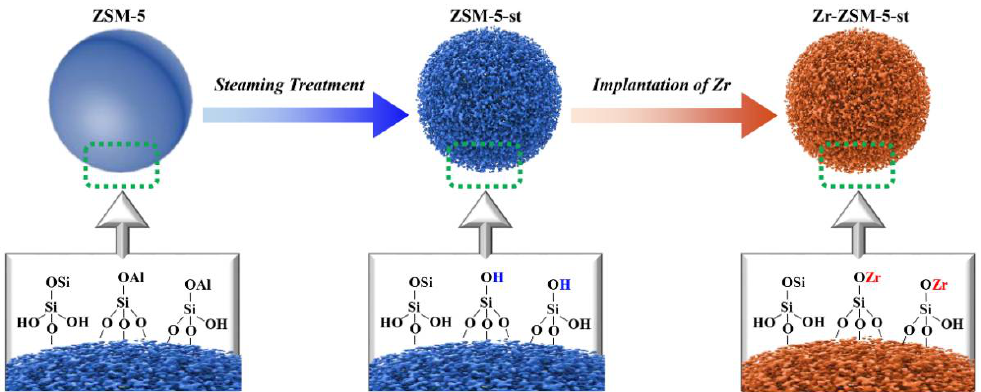
Figure 3. Plausible formation mechanism of the Zr-ZSM-5-st catalyst.